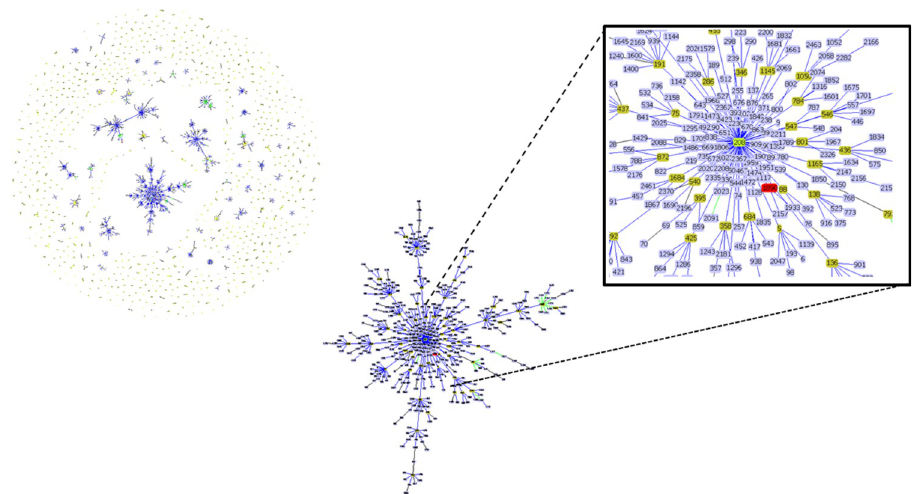
Fig 1. Genetic population structure of A . baumannii obtained by goeBURST analysis using the 2,479 ST currently deposited in the MLST database. Two STs are linked when they differ in just one of seven loci (SLV analysis). Single STs represent singletons. goeBURST clonal cluster CC208 containing ST1890 (in red) found in this study. The putative founding and subgroup genotype are indicated in green and yellow, respectively.